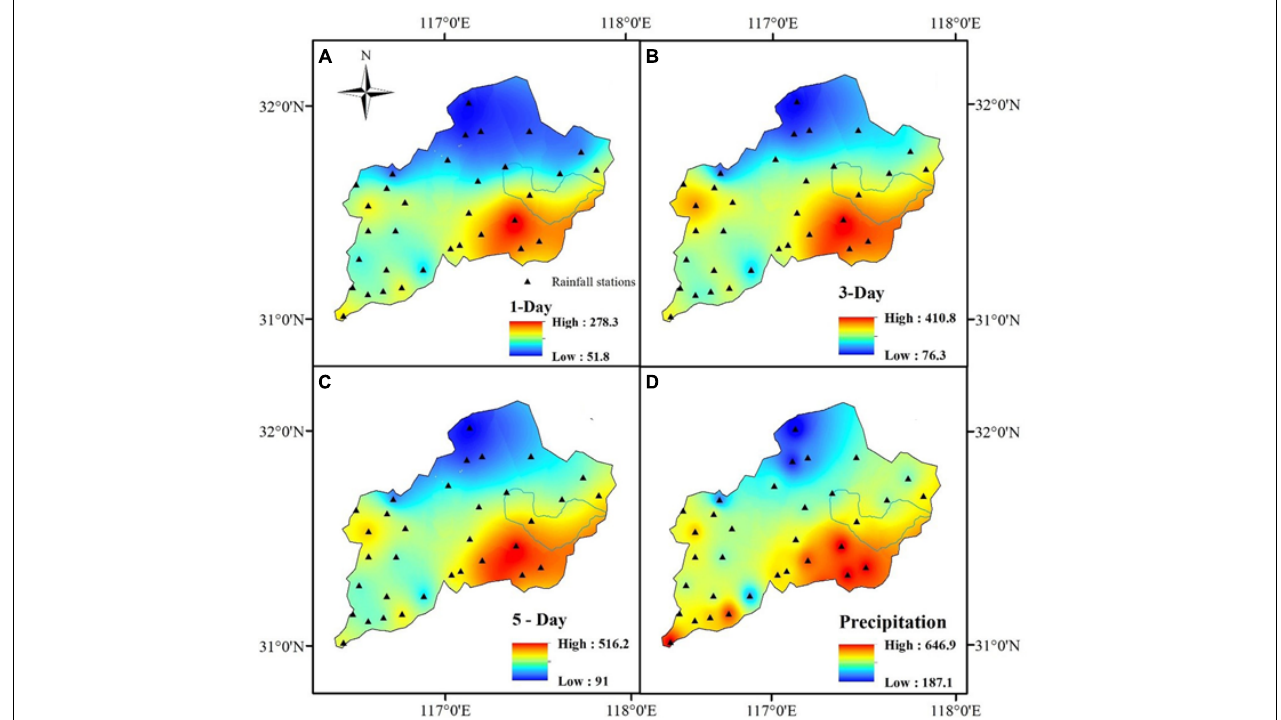
FIGURE 7 | Spatial distributions of total maximum precipitation in 1-day (A) , 3-day (B) , 5-day (C) , or total precipitation volumes (D) in the July 1, 2016 flood event (Units: mm).